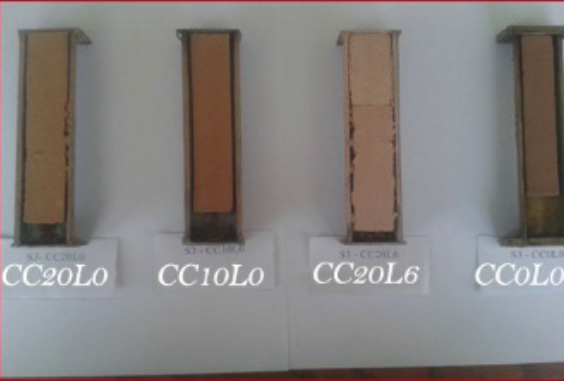
Figure 8. Photograph of soil S3 (some untreated and treated samples). Figure 8: Photograph of soil S3 (some untreated and treated samples). Table 8: Linear shrinkage values of the investigated clay mixtures.